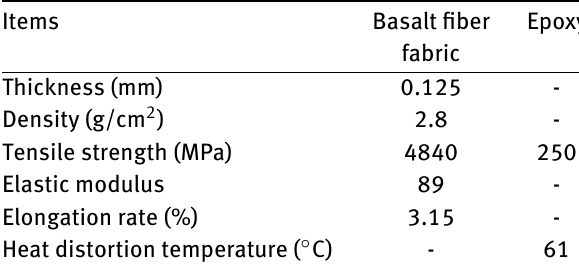
Table 1: Material properties of basalt fiber fabric and